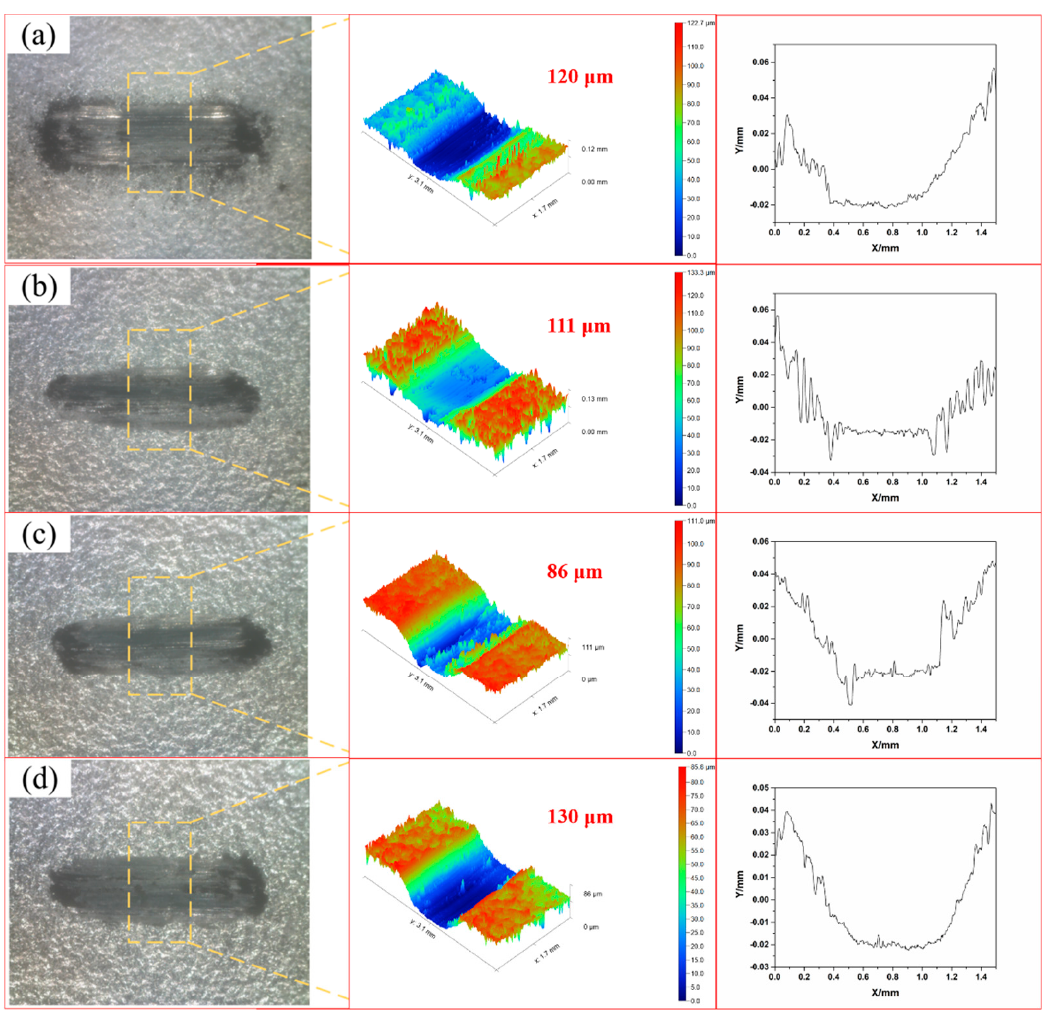
Figure 5. Wear scar morphology of each sample under different loading energy densities: ( a ) not cleaned; ( b ) 8.5 J/cm 2 ; ( c ) 10.5 J/cm 2 ; ( d ) 12.5 J/cm 2 .